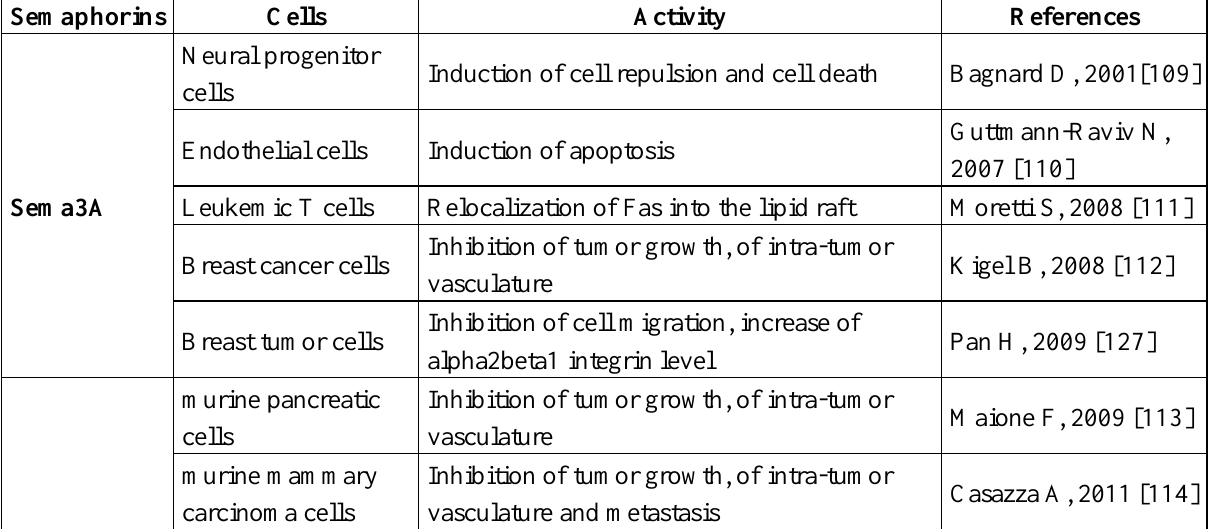
Table 2. Class 3 semaphorins expression and function in tumor